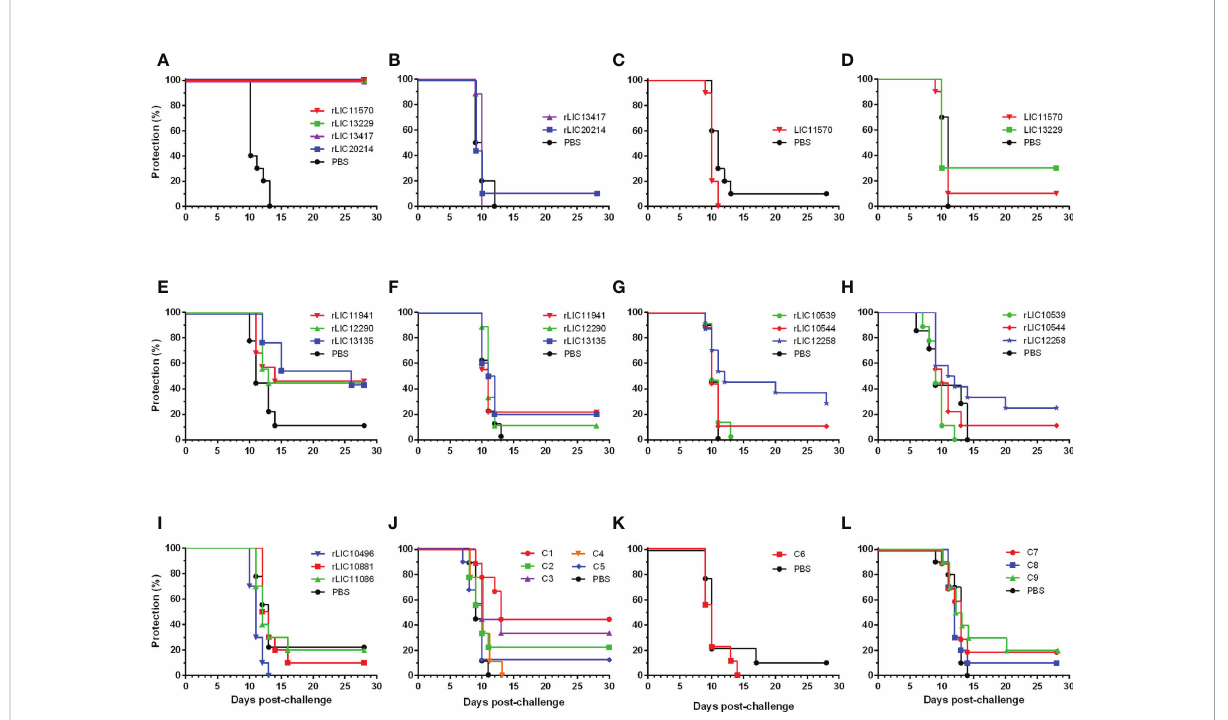
FIGURE 3 Protection against lethal challenge in the hamster model of acute leptospirosis. Representative experiments showing survival of hamsters vaccinated (days -28 and -14) with two doses of the r b b-OMPs vaccine candidates or injected with a PBS control, followed by challenge (day 0) with a lethal dose of L. interrogans serovar Copenhageni strain Fiocruz L1-130, see (Table 2). Groups of hamsters were vaccinated with: (A) rLIC11570 (GspD), rLIC13229 (AlgE), rLIC13417* (AlgE), rLIC20214 (TBDR) or the PBS control. All the r b b-OMPs induced 100% protection ( P < 0.0001) and sterilizing immunity; (B – D) repeat experiments failed to reproduce the protective immune response seen previously; (E) vaccinated with the OEPs rLIC11941, rLIC12290, rLIC13135 or the PBS control. While the level of protection was the same (44.4%) for all proteins, only rLIC13135 signi fi cantly increased survival ( P < 0.05) among vaccinated hamsters compared to the PBS control group; (F) a repeat experiment using the OEPs failed to reproduce these results; (G, H) vaccinated with rLIC10539 (Omp85), rLIC10544 (porin), rLIC12258 (Omp85) or the PBS control. None of the vaccine preparations protected against the challenge dose; (I) , vaccinated with rLIC10496 (TolC), rLIC10881* (TBDR), rLIC11086 (AlgE) or the PBS control. None of the vaccine preparations protected against the challenge dose; (J) , hamsters were vaccinated with chimeras C1-C5 or the PBS control. While none of the chimeras protected against the lethal challenge, chimeras C1 (TBDRs: LIC10896* + LIC10964 + LIC12374) and C3 (LIC11458 (LptD) + LIC11506 (OmpG) + LIC11086 (OM channel) + LIC20019 (porin)) signi fi cantly increased survival compared to the PBS control group; (K, L) , hamsters vaccinated with chimeras C6-C9 or the PBS control group. None of the chimeras induced a signi fi cant protective immune